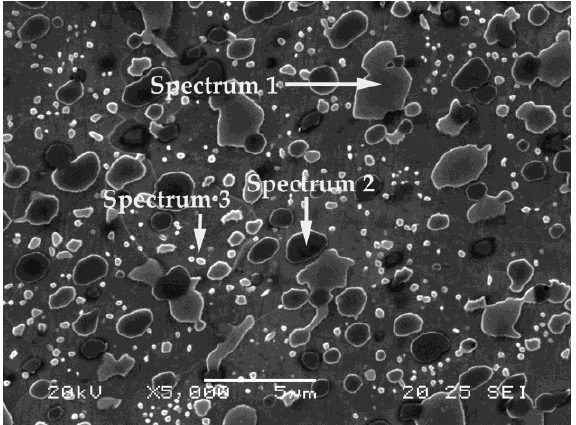
Figure 2. Microstructure of Vanadis 10 steel in the annealed state. Table 4. Analysis of the phases listed in Figure 2, determined by the characteristic energy dispersive X-ray (EDX) microanalysis. Results are presented in atomic